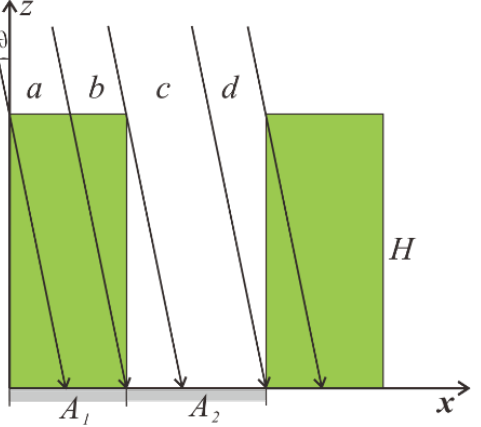
Figure 2. Illustration of average gap fraction calculation of row crops in a vertical plane with x points to an azimuth angle of  (the azimuth increases in the clockwise direction with its origin along the row direction). A = A 1 + A 2